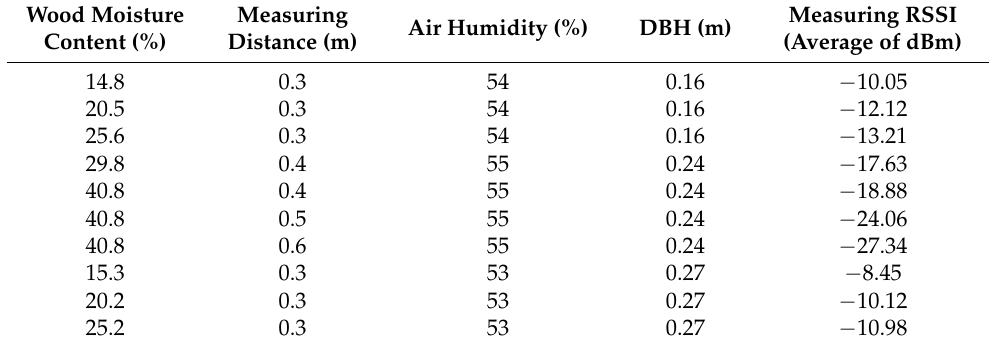
Table 2. Components of typical measuring